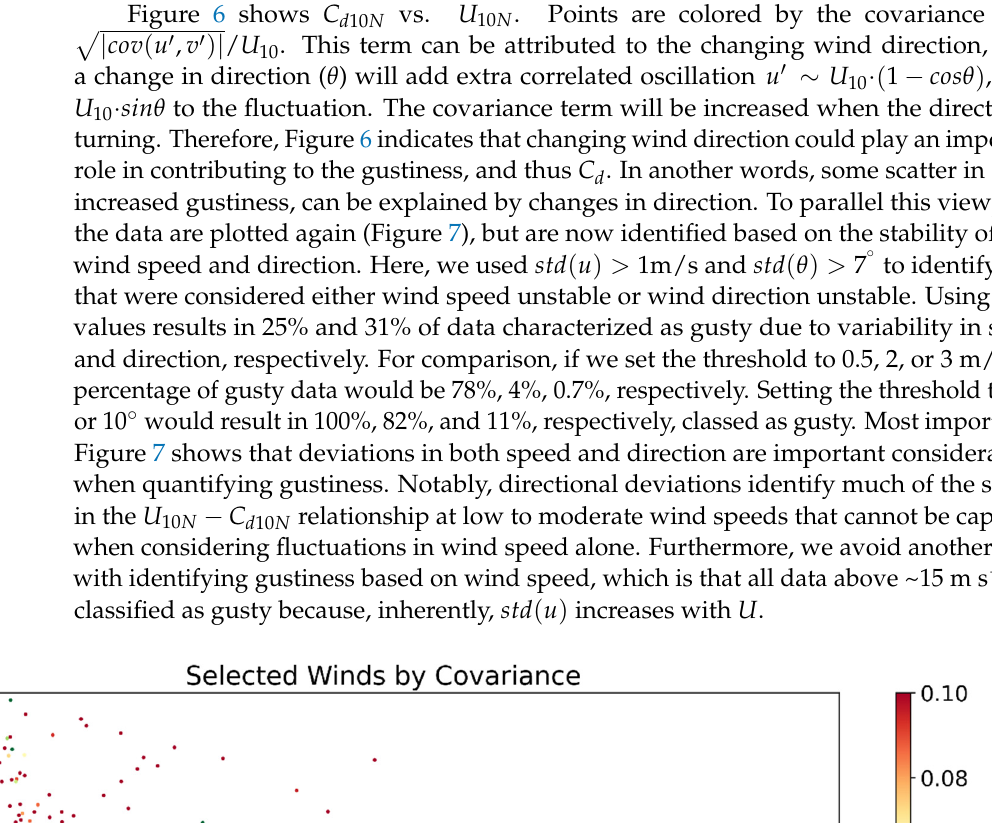
Figure 5. C d of gusty winds (red & yellow points) and not-gusty winds (green points) selected by G A . Non-gusty winds are selected by the condition G A ≤ 0.165 and marked as green. The blue line is the averaged C d for G A ≤ 0.165 with error bars denoting 95% confidence interval binned every 2.5 m/s. The orange line is the averaged C d for G A > 0.165 with error bars also denoting 95% confidence interval binned every 2.5 m/s. The black dash line is the C d 10 N predicted by [25]. The red line is C d 10 N predicted by COARE 3.0 algorithm [30].